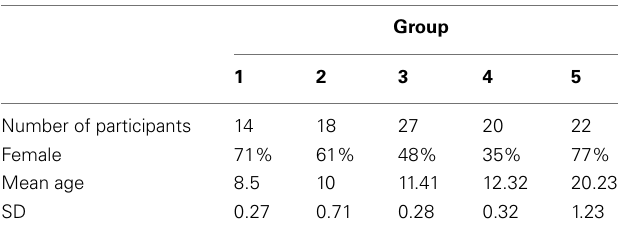
Table 1 | Descriptives of sample sizes, gender distribution, and mean age in years (SD) of the five age groups.